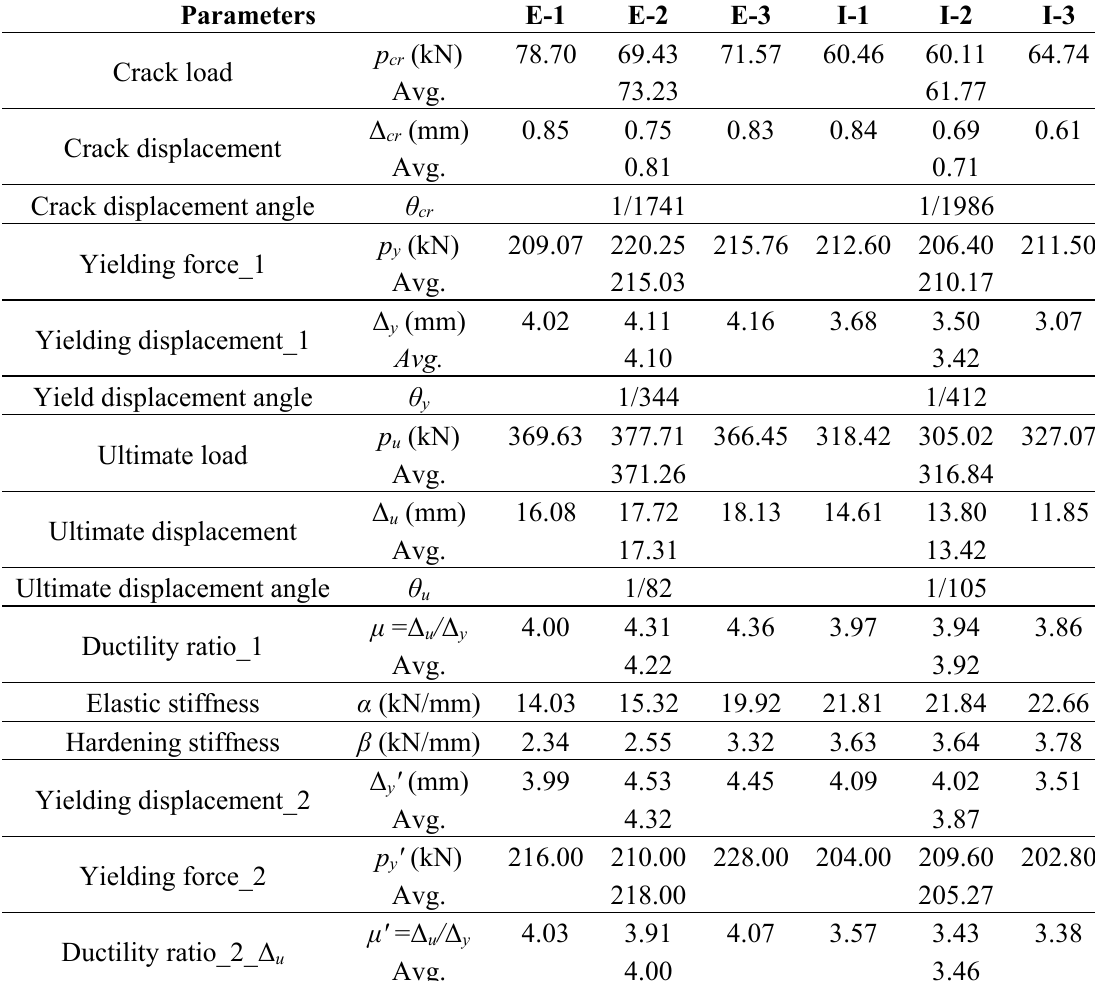
Table 1. Load-carrying capacity and ductility